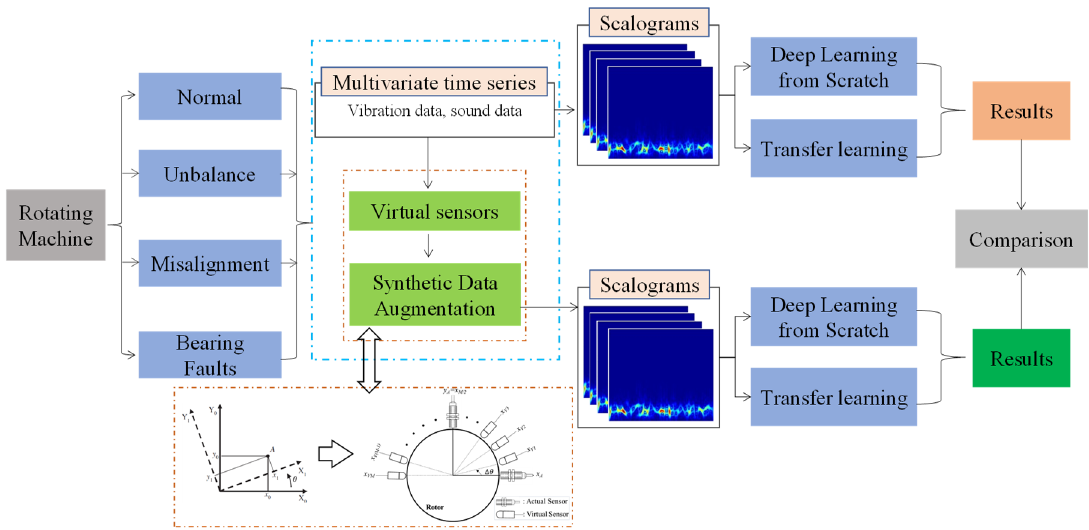
Figure 1. Proposed methodology of synthetic data augmentation for fault diagnosis.